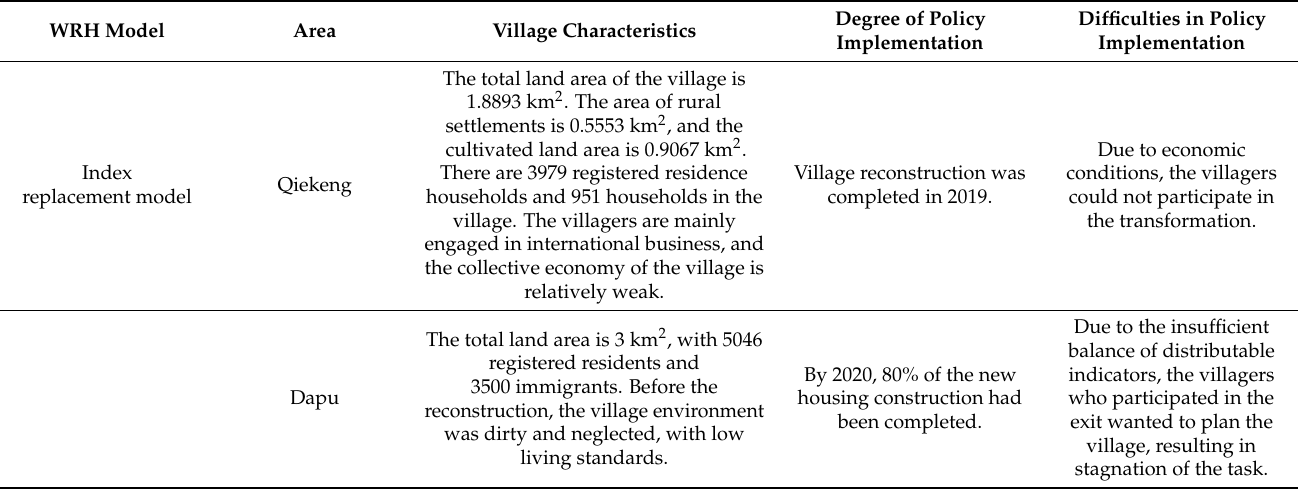
Table 1. Descriptions of study